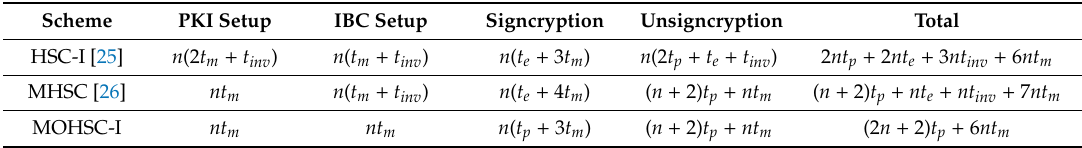
Table 2. Computation comparisons (public key infrastructure (PKI) → identity-based cryptosystem